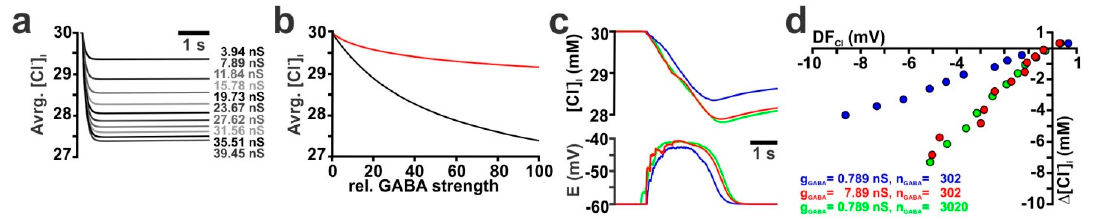
Figure 3. Influence of the GABAergic conductance (g GABA ) on GABA-induced [Cl ⁻ ] i transients. ( a ) Time course of average [Cl ⁻ ] i in an isolated dendrite upon single synaptic stimulation using g GABA between 3.945 nS and 39.45 nS. (b) Average [Cl ⁻ ] i in an isolated dendrite stimulated at a single synapse with g GABA between 0.789 nS (red trace) and 78.9 nS (black trace). Note the non-linear dependency between [Cl ⁻ ] i changes and g GABA . In an additional set of simulations, the total GABAergic current was varied by increasing the number (n GABA ) of evenly distributed single synapses (with g GABA = 0.789 nS) from 1 to 100 (red trace). Note that under these conditions, smaller [Cl ⁻ ] i changes occur. (c) GDP-induced average [Cl ⁻ ] i and E m changes in a reconstructed CA3 pyramidal neuron under control conditions ( τ = 37 ms, P HCO3 = 0, g GABA = 0.789 nS, n GABA = 302, blue trace) and upon enhanced stimulation by either increasing the conductance (g GABA = 7.89 nS, n GABA = 302, red trace) or the number of synapses (g GABA = 0.789 nS, n GABA = 3020, green trace). ( d ) Dependency between DF Cl and the GDP-induced [Cl ⁻ ] i transients obtained with different stimulation conditions.